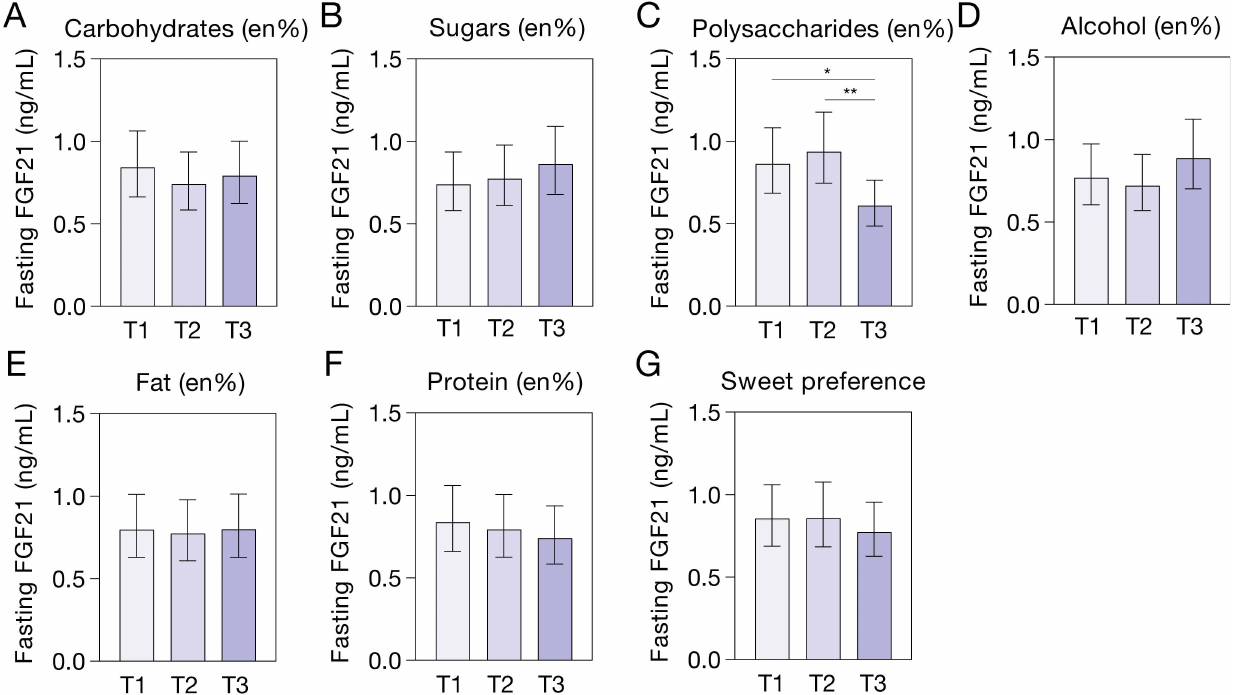
Figure 3. Fasting plasma FGF21 levels (adjusted geometric means with 95% CI) according to tertiles (T1: lowest tertile, T3: highest tertile) of habitual (macro)nutrient intake as % of daily energy intake (en%) ( A – C , E , F ), habitual alcohol consumption ( D ), and sweet-taste preference ( G ). FGF21 levels were lower in the highest tertile of polysaccharide intake compared to the lower tertiles (overall p = 0.022; tested by ANCOVA with adjustment for gender and LSD post-hoc testing; * p = 0.035; ** p = 0.009) and did not differ between tertiles of other nutrient